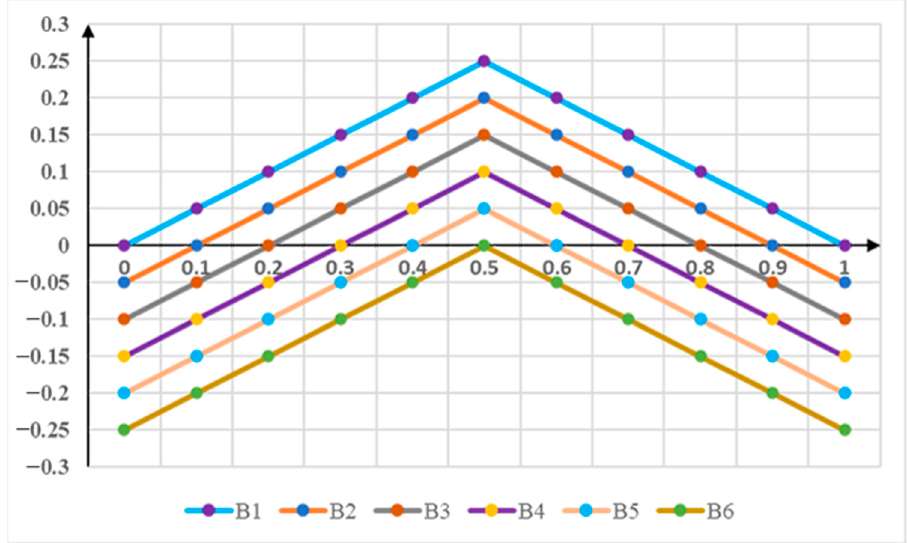
Figure 5. The dominant value curves of decision 𝑎 (cid:3003) under different 𝜎 . Figure 9. The dominant value curves of decision a B under different σ